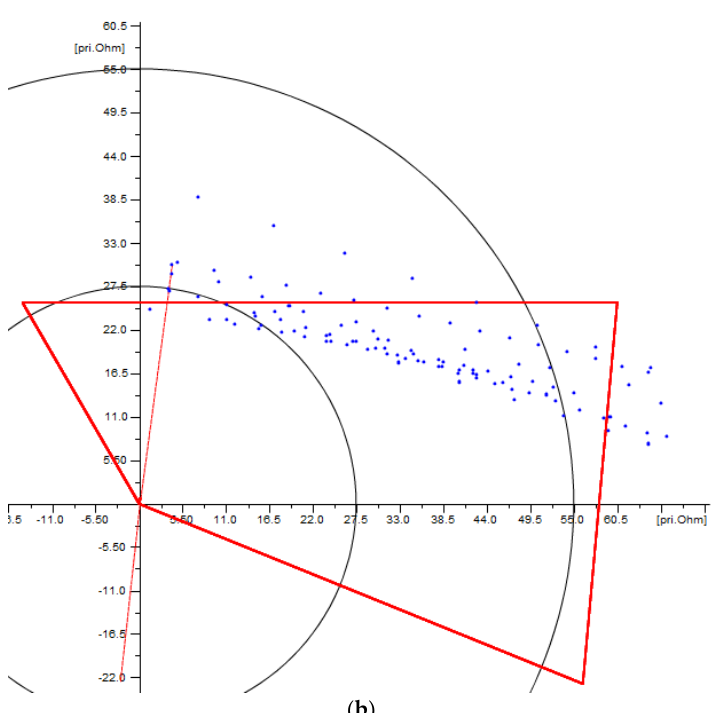
Figure 4. Measured impedances for faults ( a ) inside the expected range of influence of Zone 1, and ( b ) outside the expected range of influence of Zone 1.